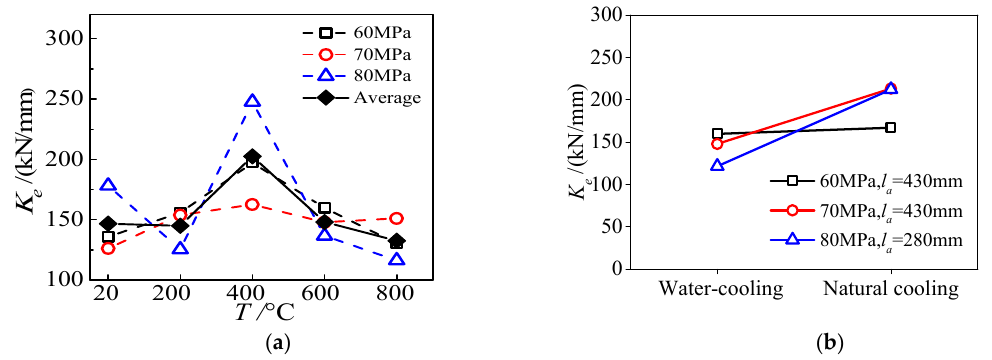
Figure 20. Shear bond stiffness of specimens ( a ) maximum temperature; ( b ) cooling method.